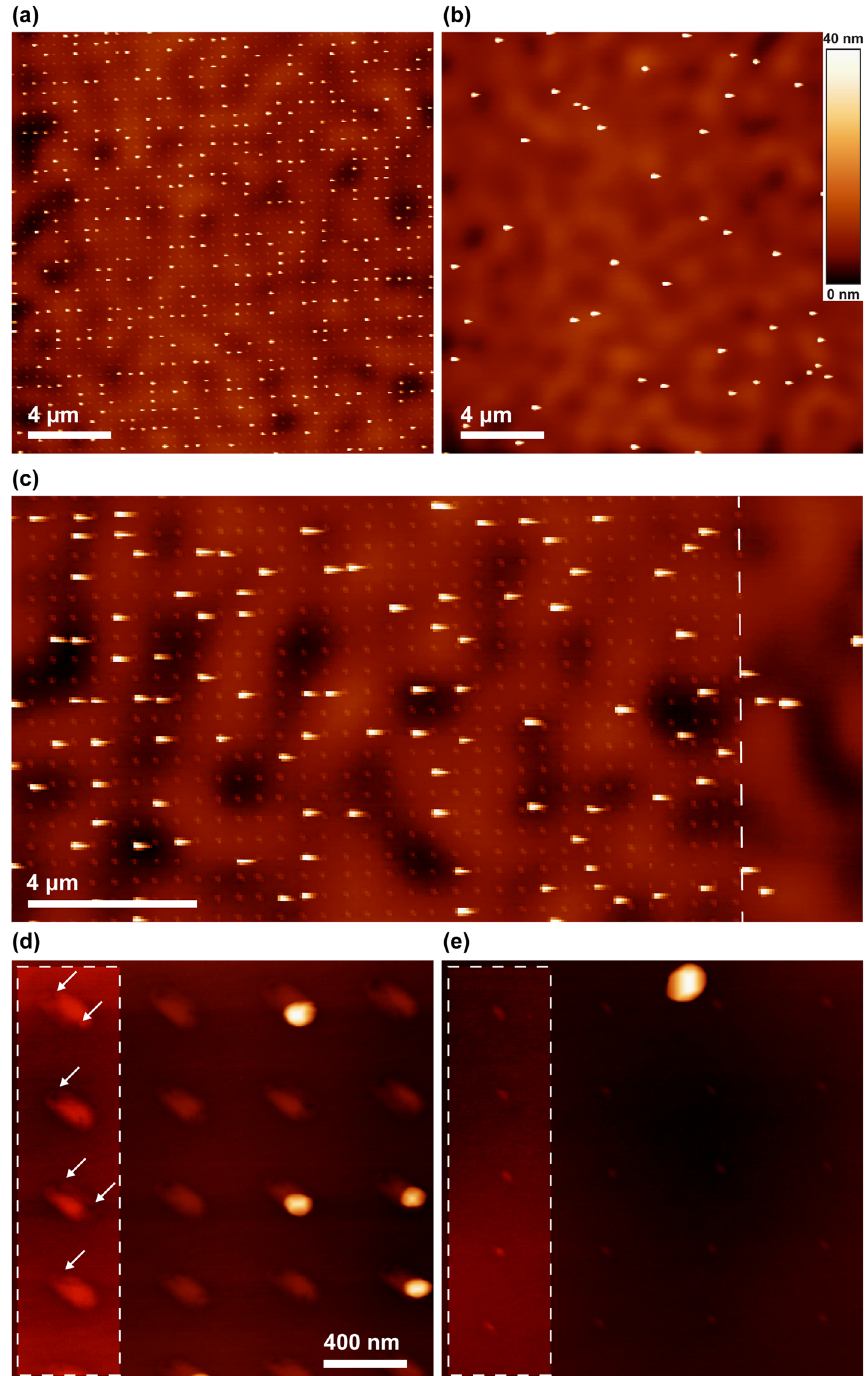
Figure 1. ( a ) Atomic force microscopy (AFM) image of Ge quantum dots grown on Si(100) patterned with 60 keV Si 2 + ions at 1 × 10 6 ions per spot in a square array of spots (500 nm separation). The implanted spots show up as shallow surface bumps and Ge quantum dots as the brighter spots. ( b ) AFM image of an area of the sample that did not undergo implantation. ( c ) Image acquired near the edge of the implanted region (indicated by the dotted line) showing the transition in quantum dot growth density. The shapes are distorted due to the speed of the scan. ( d , e ) Higher magnification images of two areas implanted with doses of 1 × 10 6 and 1 × 10 5 ions per spot respectively followed by Ge quantum dot growth. In ( d ), shallow bumps and pits (white arrows) are visible at implant sites. In ( e ) the bumps are smaller than in ( d ), no pits are visible and there is no correspondence between quantum dots and the implantation pattern. In both images the brightness and contrast in the dotted rectangle are adjusted to accentuate the features. We attribute the asymmetric shape of the surface bumps to residual astigmatism in the Si 2 + ion